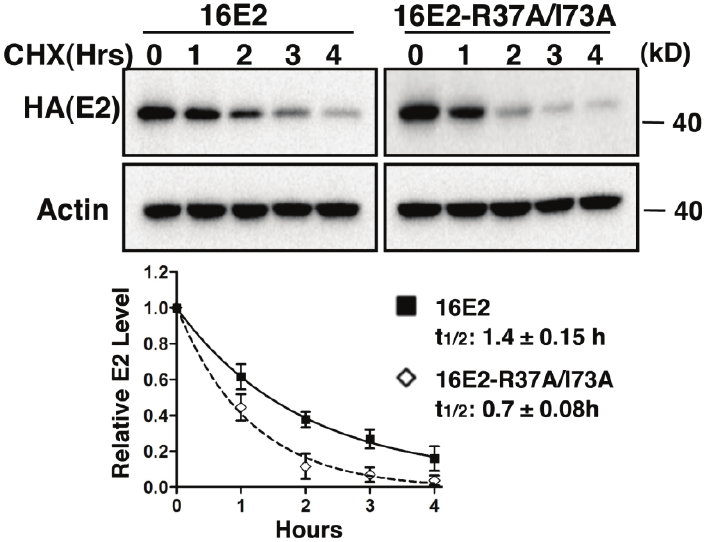
Figure 4. Disruption of E2 interaction with endogenous Brd4 decreases E2 protein stability. C33A cells were transfected with pOZN-16E2 or pOZN-16E2-R37A/I73A expression construct. Cells were treated with 100 μ g/mL cycloheximide (CHX) at 24 h after transfection for the lengths of time indicated. Cell lysates were harvested